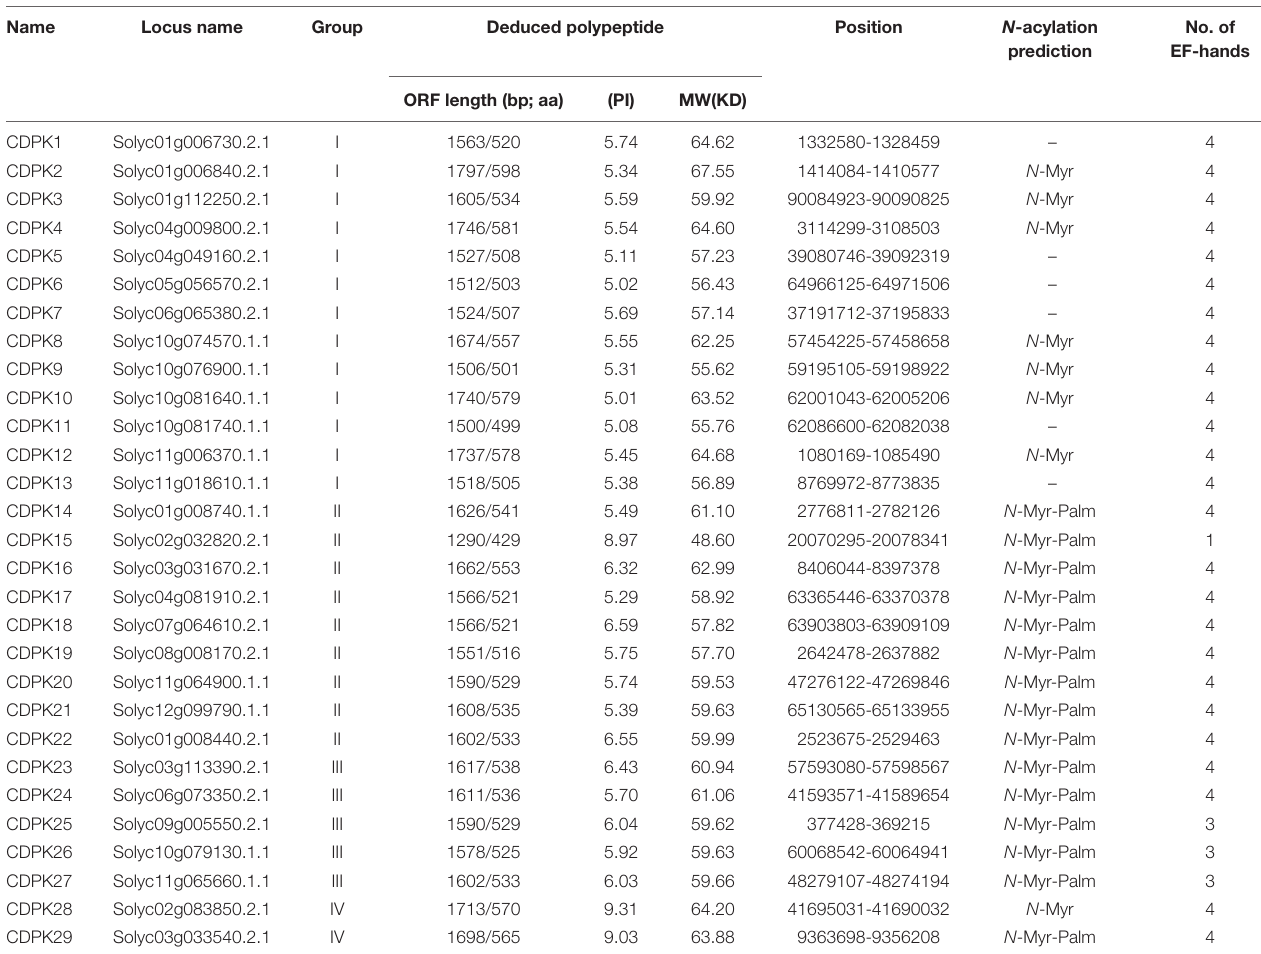
TABLE 1 | Characteristics of calcium-dependent protein kinases (CDPKs) in